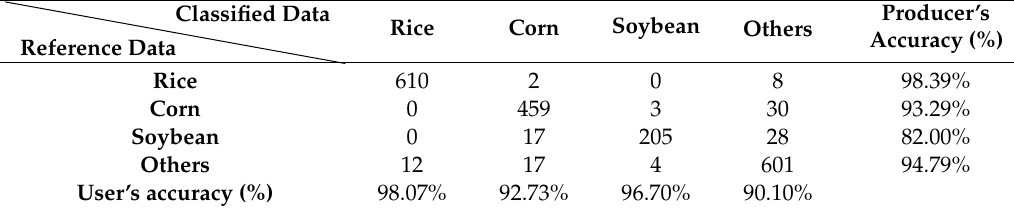
Figure 7. ( a ) Rice probability map with optimized features for rice. ( b ) Corn probability map with optimized features for corn. ( c ) Soybean probability map with optimized features for soybean. Table 4. Confusion matrix of crop layer with